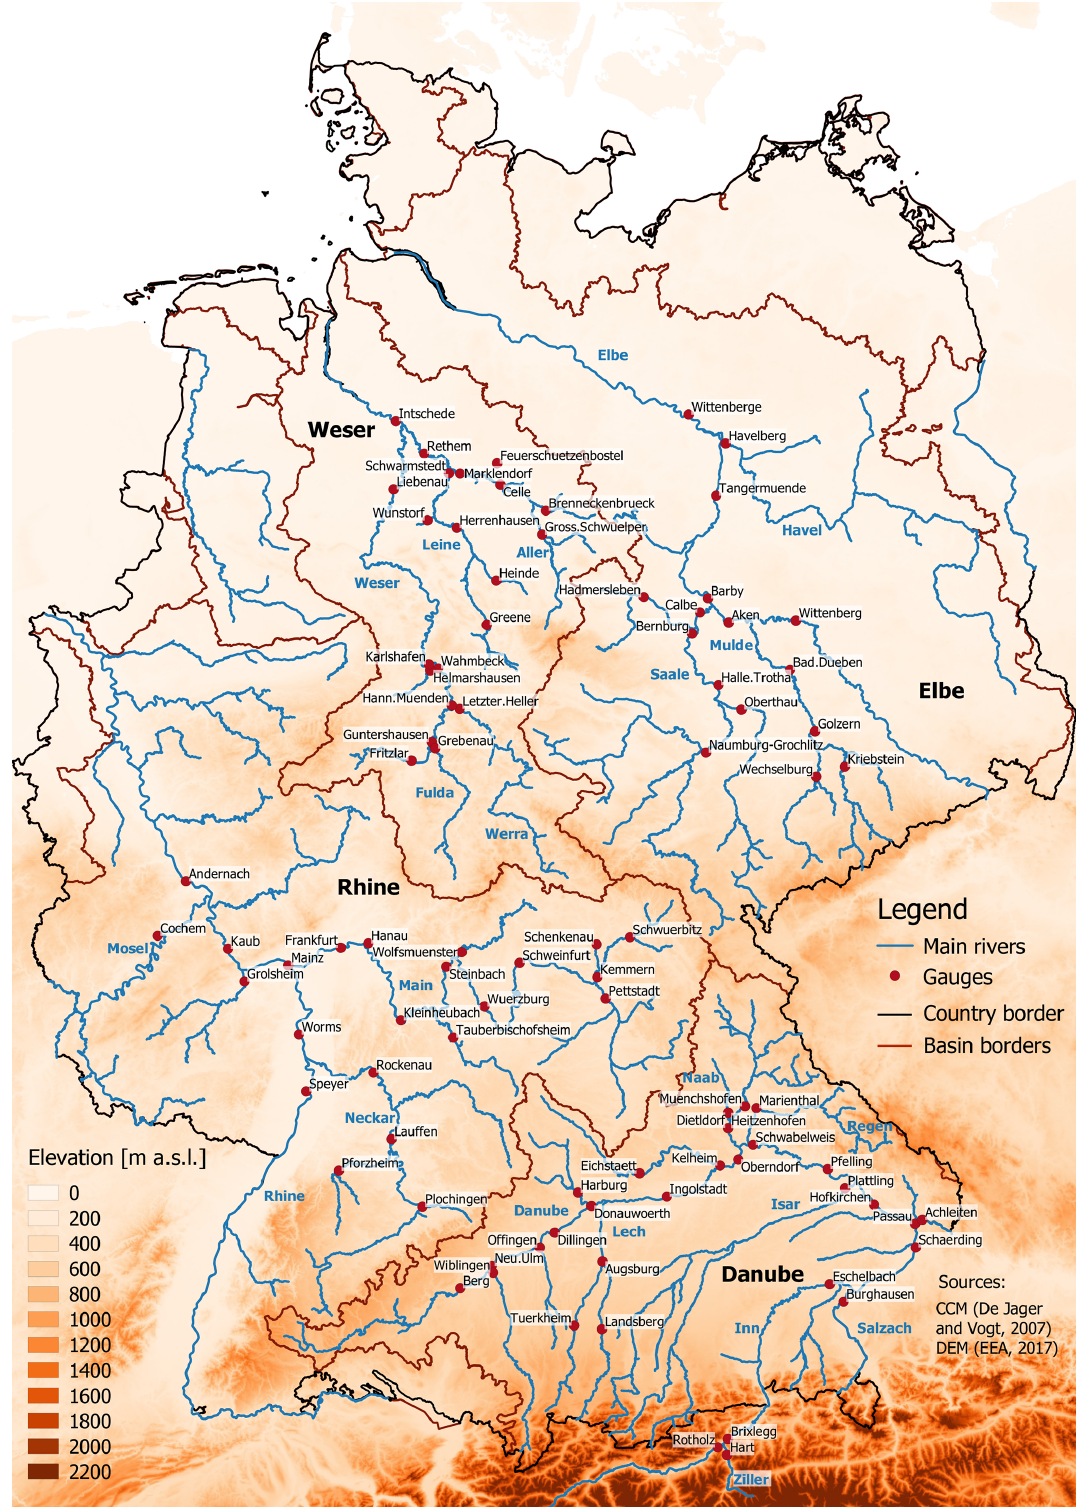
Figure 1. Map of Germany showing the catchment elevation, major basins, rivers and